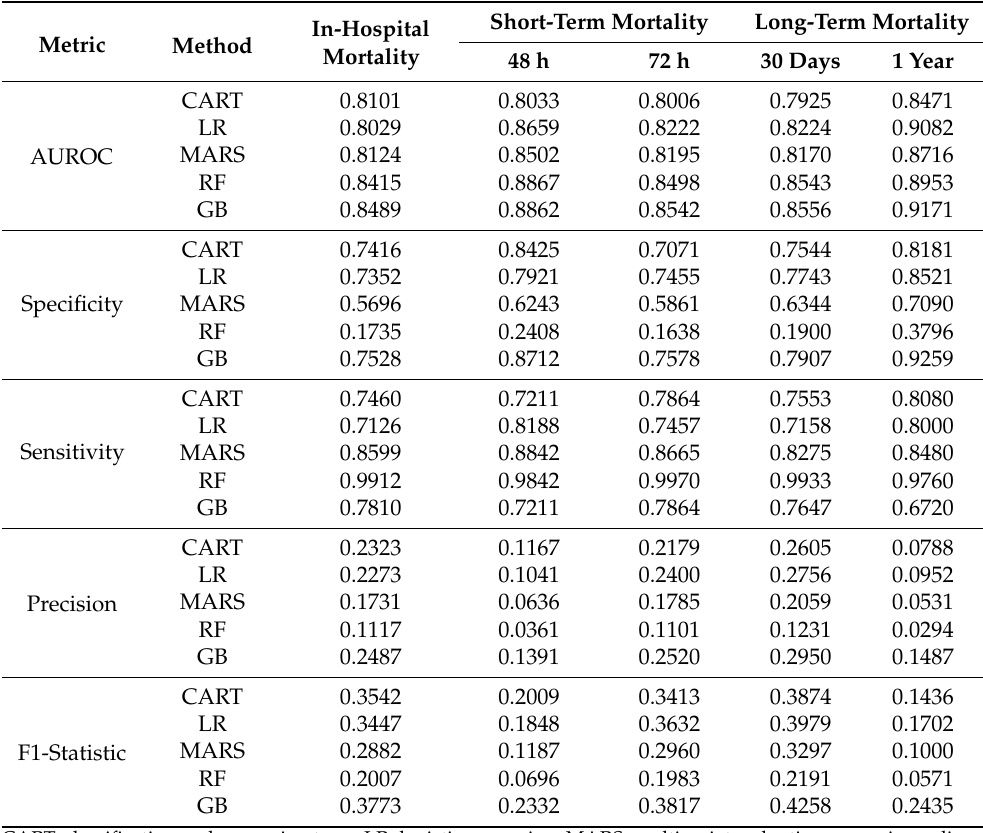
Table 6. Comparisons between different models constructed using 12 h dataset in terms of their prediction accuracy.